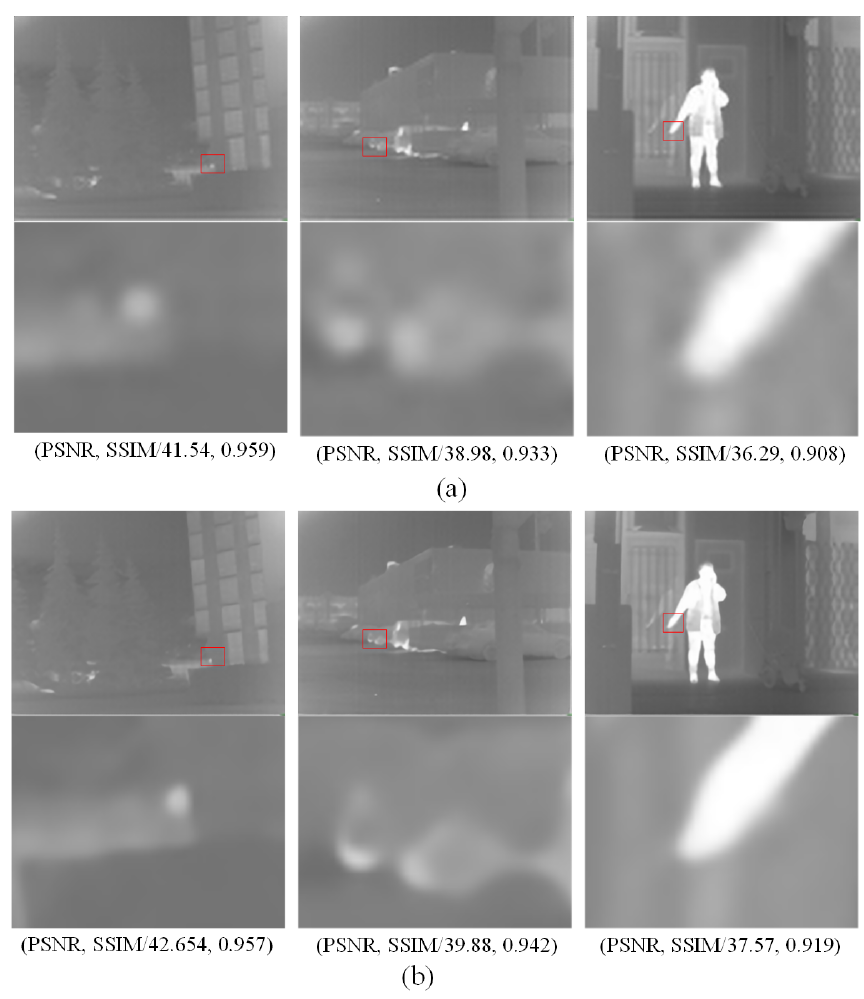
Figure 14. Comparison on the proposed method without denoising and the proposed method with denoising. ( a ) is the result of the proposed method without denoising; ( b ) is the result of the proposed method with denoising.